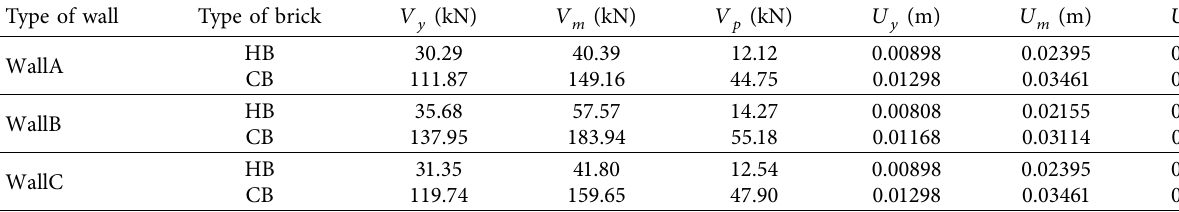
Table 3: Lateral resistance and deformation of masonry-inflled walls.